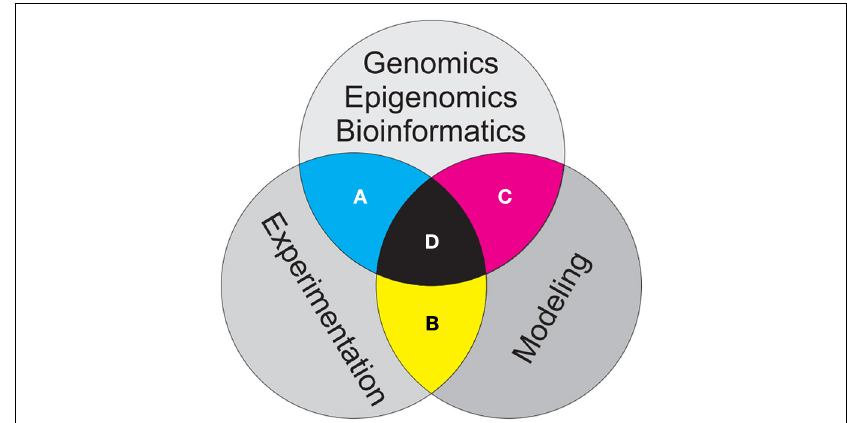
FIGURE 1 | Schematic showing three major branches of evolutionary and population genetics addressed in this essay. Bioinformatics work to develop, curate, archive and analyze genomic and epigenomic data, modeling of the influences of population processes on genomic and epigenomic patterns within populations and controlled and replicated experiments to test hypothesized relationships are all critical to advancing our field. The greatest challenges and opportunities lie in the intersections among these three branches of research. (A) Bioinformatics should inform design of experiments, and results of genetic experiments should guide what genomic and epigenomic data are collected for a given research effort. (B) Modeling should guide design of experiments and generalize and extend experimental results to explore implications of pattern-process relationships across scale, and experiments should guide the parameterization and calibration of models. (C) Bioinformatics should provide modelers with genomic and epigenomic data appropriate for model development, calibration, optimization and validation, while models should inform bioinformaticians as to which genomic and epigenomic data is most relevant for a particular question. The three way intersection of bioinformatics, modeling, and experimentation (D) provides the strongest potential synergy to advance evolutionary and population